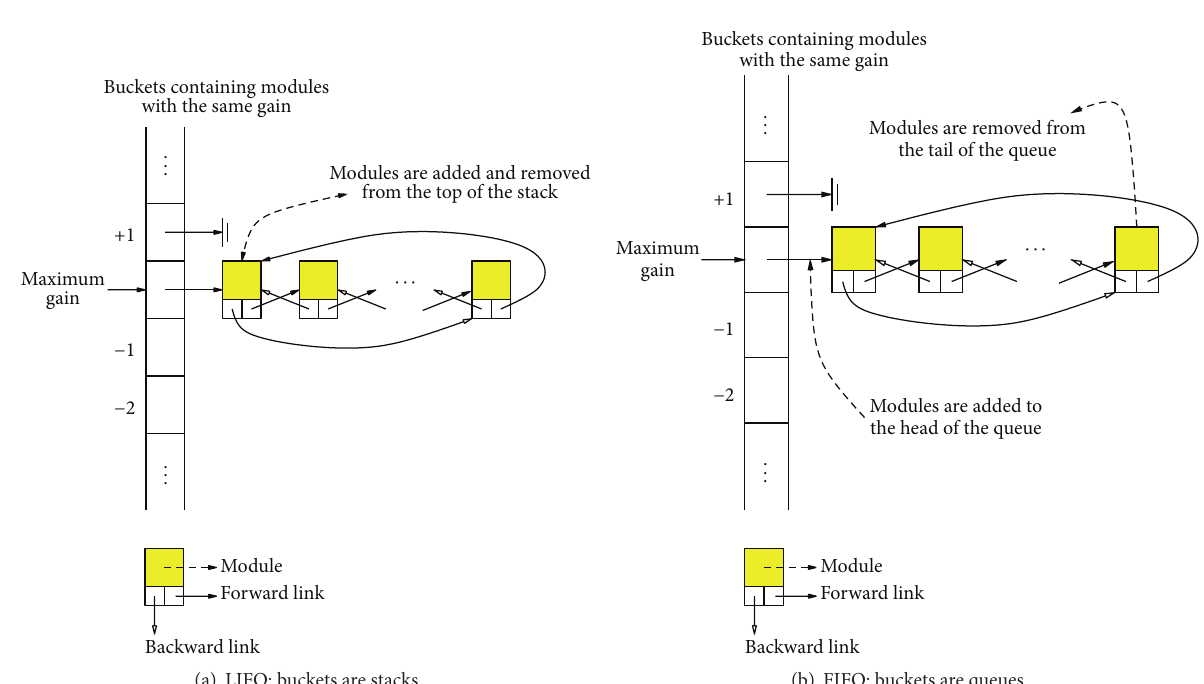
Figure 1: LIFO and FIFO management of gain buckets. In our implementation, circular doubly linked lists are used for efficient bucket management.